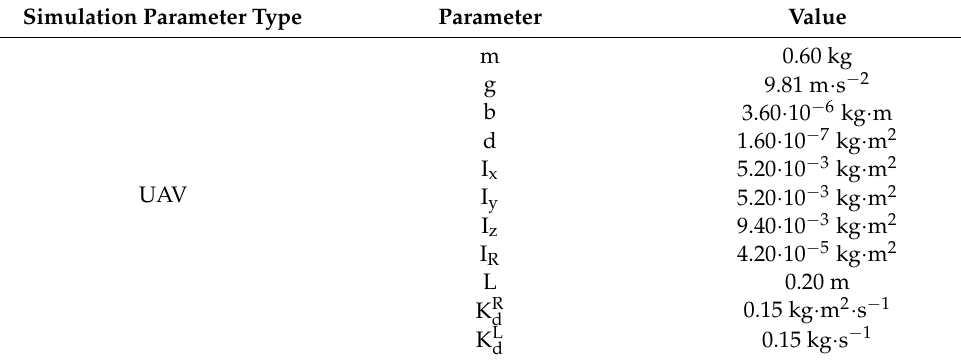
Table 1. Simulation